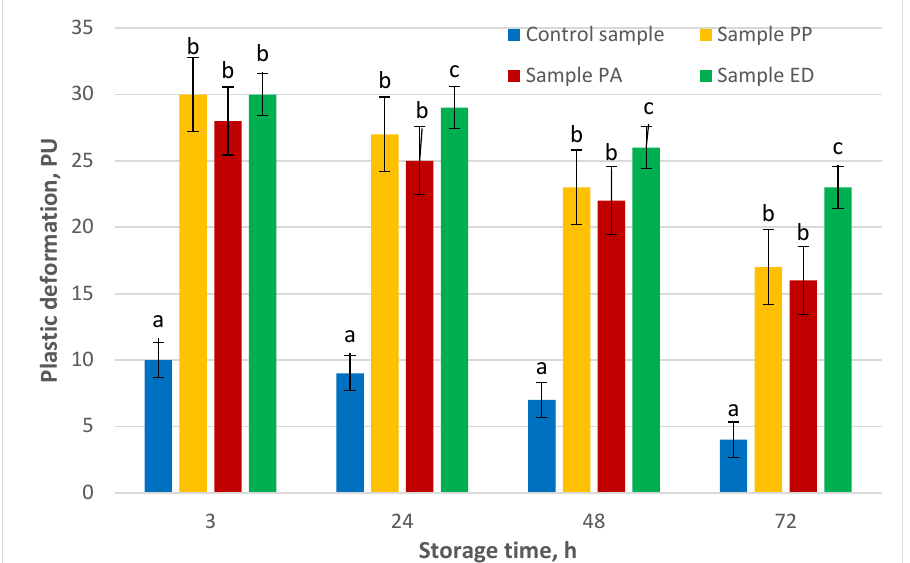
Figure 4. Effect of lactic acid bacteria on the plastic deformation of nongluten bread. Note: PU — penetrometric units; PA — sample with Pediococcus acidilactici 02P108; PP — sample with Pediococcus pentosaceus 12R2187; ED — sample with Enteroccocus durans 09B374. Different small letters for each time measurement indicate significant difference between mean values ( p < 0.01).